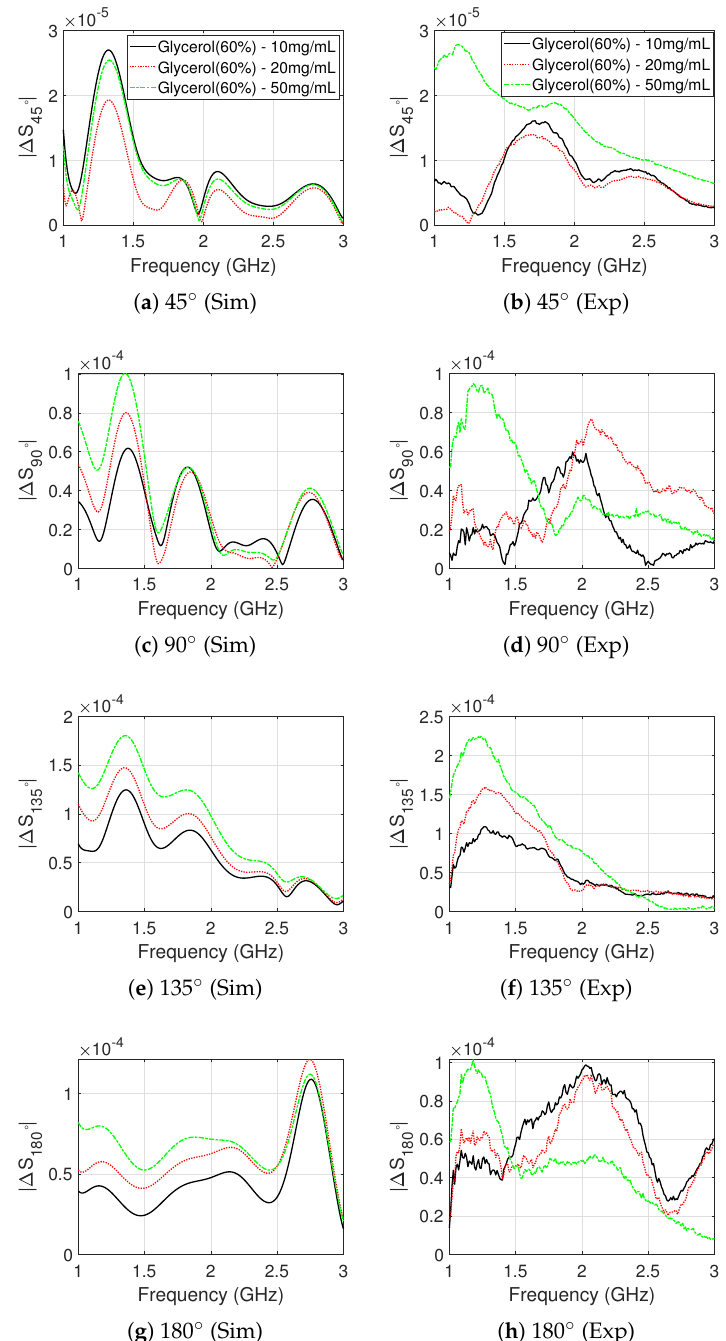
Figure 5. Difference in received signal strength between “no-target” and “target T2” cases, plotted for each receiver position against frequency. T2 is filled with salt concentrations between 10–50 mg/mL dissolved in 60% glycerol. The simulated ( left ) and experimental ( right ) signal differences are plotted between 1.0–3.0 GHz, which is the operational frequency range for the employed